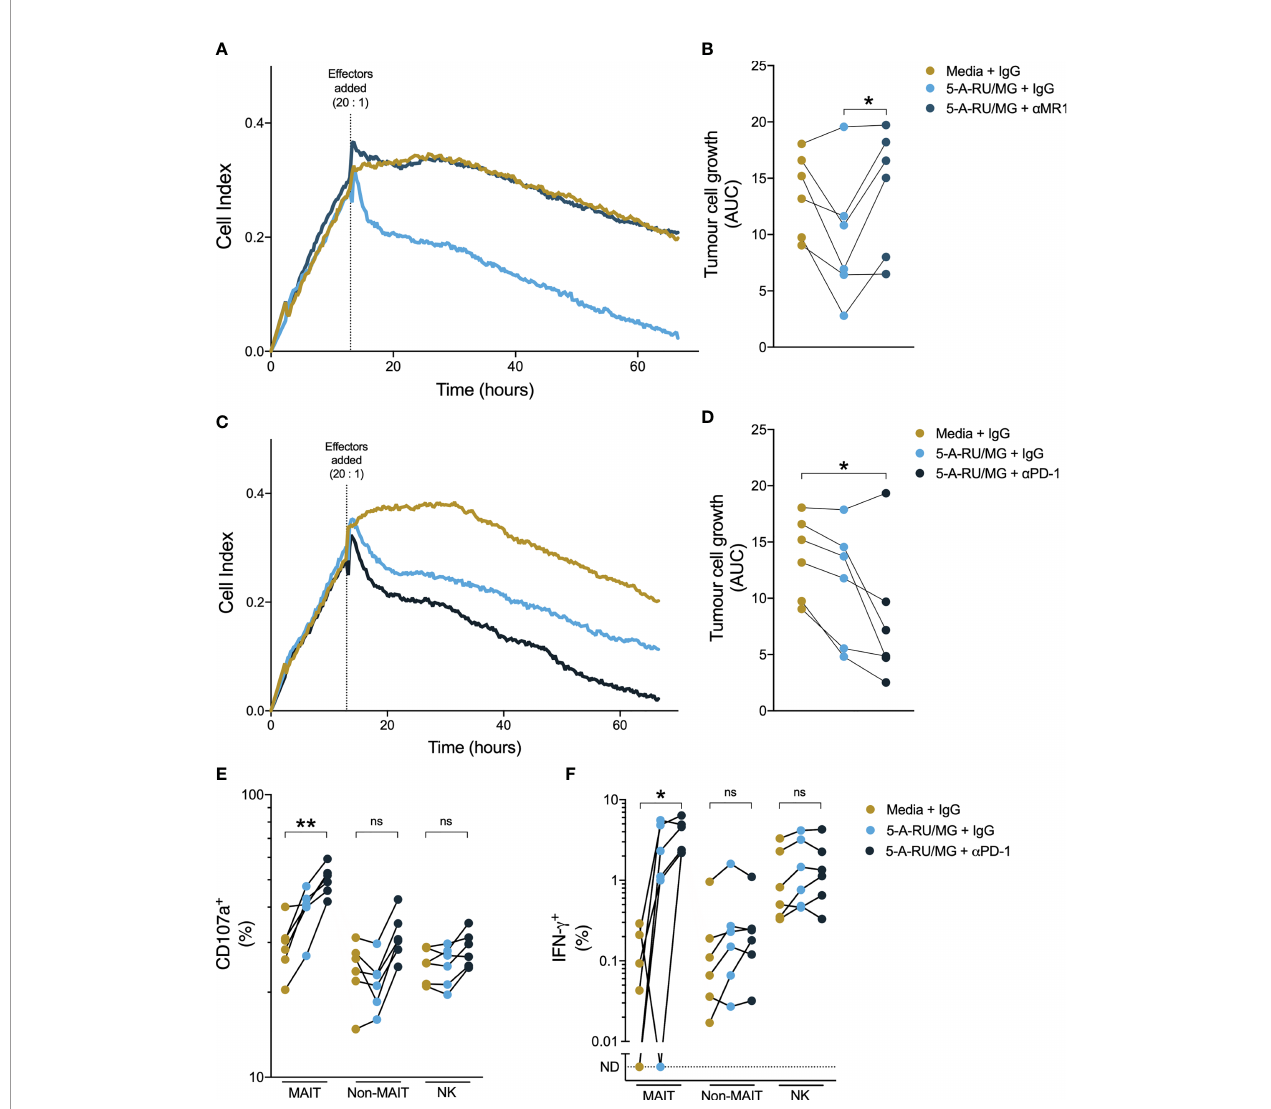
FIGURE 7 | Anti-PD-1 enhances healthy donor MAIT-cell suppression of prostate tumour growth in vitro. PC3 cells were grown in a real-time impendence based cell killing assay for 12 hours in media control or 5-A-RU/MG prior to the addition of healthy donor PBMCs. The effects of anti-MR1 (A, B) and anti-PD-1 (C, D) on tumor cell growth were calculated as the area under the curve. PC3 cells were primed with 5-A-RU/MG or media control and co-cultured with healthy donor PBMCs overnight and the CD107a degranulation (E) and IFN- g expression (F) were calculated by fl ow cytometry. Friedman test with Dunn ’ s multiple comparison test. ns = no signi fi cance. *P < 0.05. **P < 0.01. N = 6 healthy